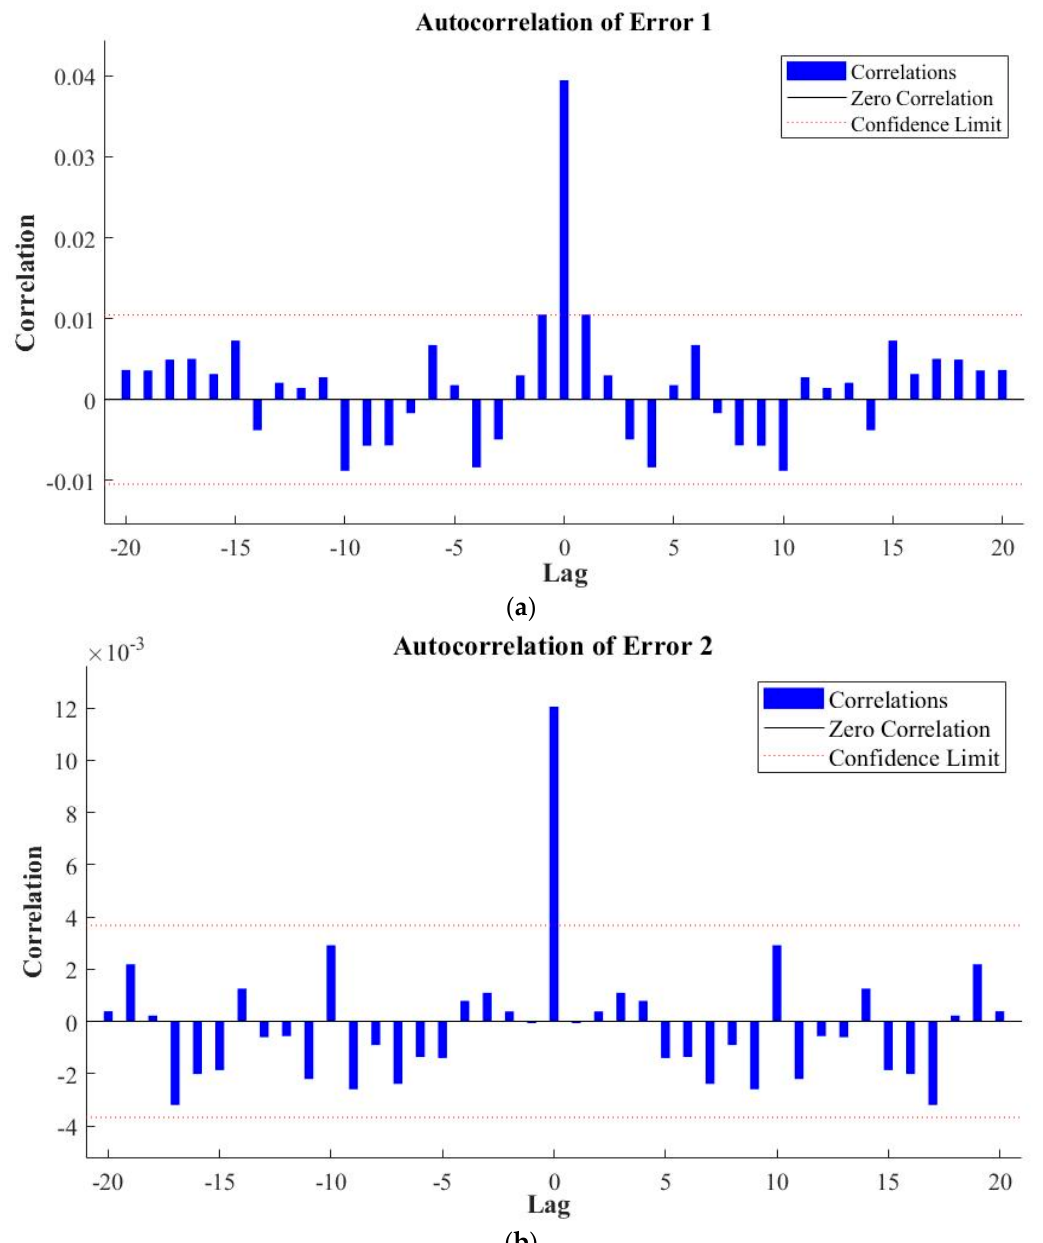
Figure 6. Autocorrelation coefficient graph after NAR modelling. ( a ) Original traffic volume time series. ( b ) SARIMA model residual series.